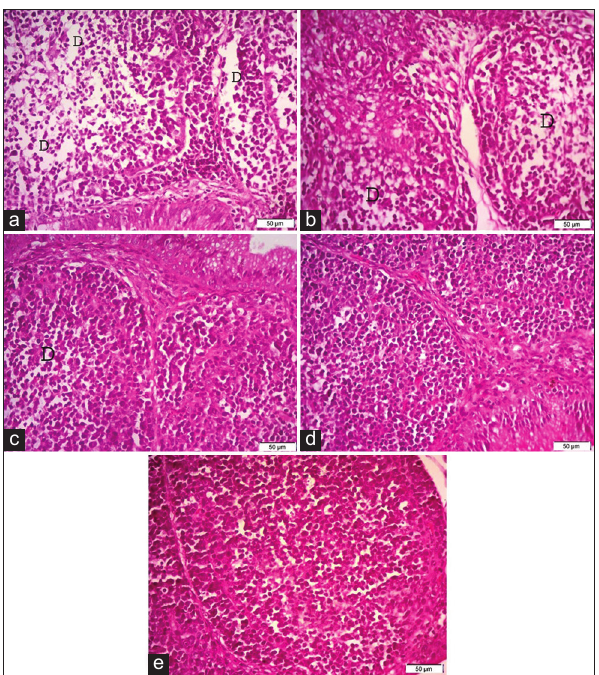
Figure-4: Photomicrographs of hematoxylin and eosin (H&E) stained sections of the thymus (a) the thymus of G1 (broilers supplemented with 0.5 g/L Bacillus subtilis ) showing severe depletion of lymphoid follicles (D). (b) The thymus of G2 (broilers supplemented with 1.0* g/L B. subtilis ). (c) The thymus of G3 (broilers supplemented with 1.5 g/L B. subtilis ). (d) The thymus of G4 (broilers supplemented with 2.0 g/L B. subtilis ). (e) The thymus of G5 (control group). H&E. (40×). Bar 50 µ